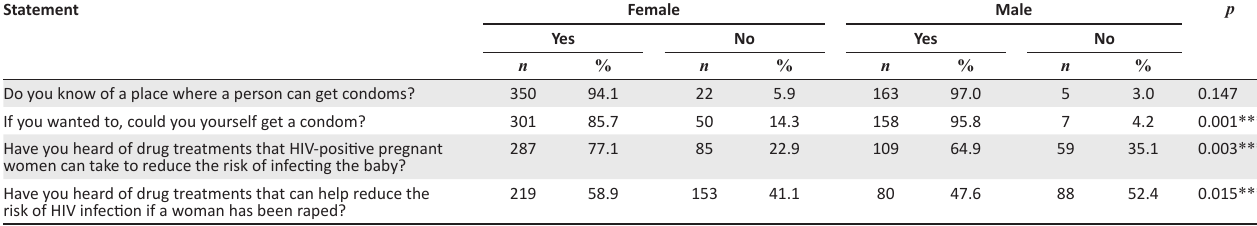
TABLE 2: Student’s knowledge of and access to HIV and AIDS prevention and control.